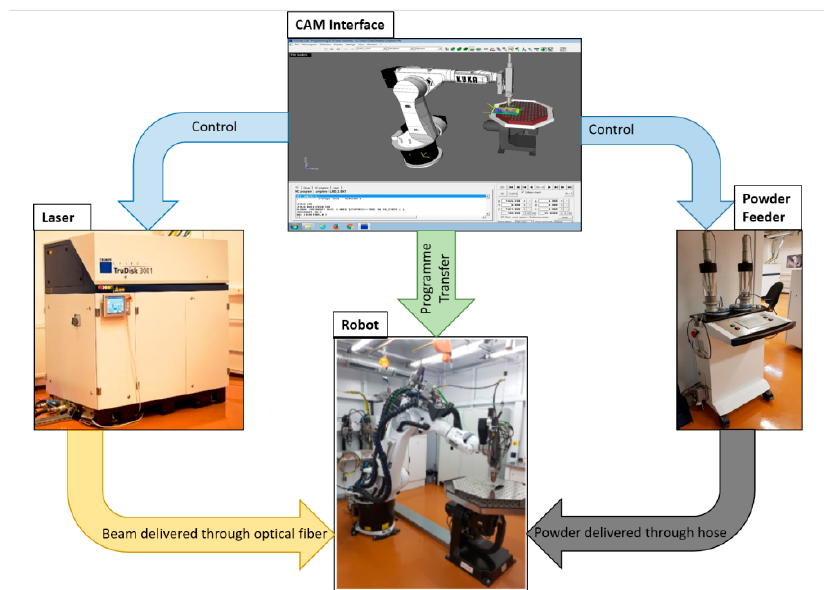
Figure 1 . The experimental set-up used for the Laser Melting Deposition (LMD) experiments, comprising a laser source TruDisk 3001, a Kr30HA robot, and a powder feeder.